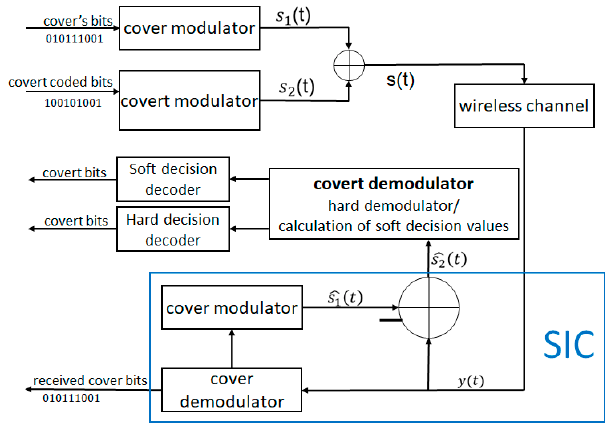
Figure 3. Transmitter/receiver structure for covert channel.